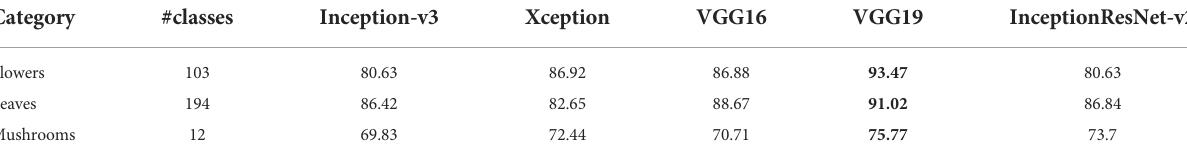
TABLE 7 Macro average test accuracies for species category on test